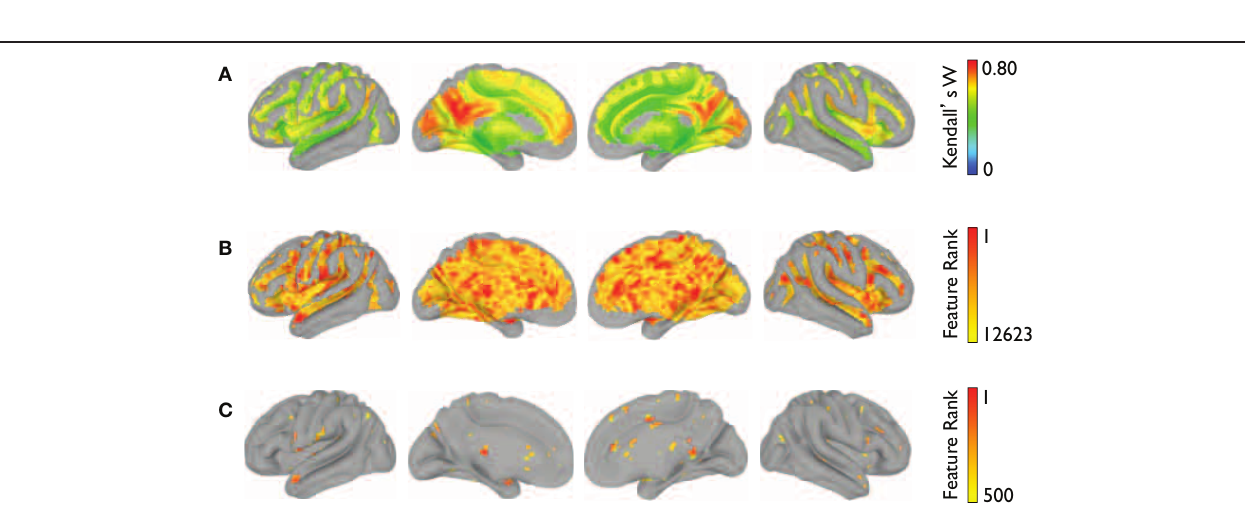
FIGURE 10 | Regional homogeneity feature rankings (NYU site). For each voxel present in all participants (across all sites), (A) the group-averaged consistency of each voxel with its (26) nearest neighbors, (B) the average feature rankings from the within-site classification, and (C) the top 500 features from the within-site classification are